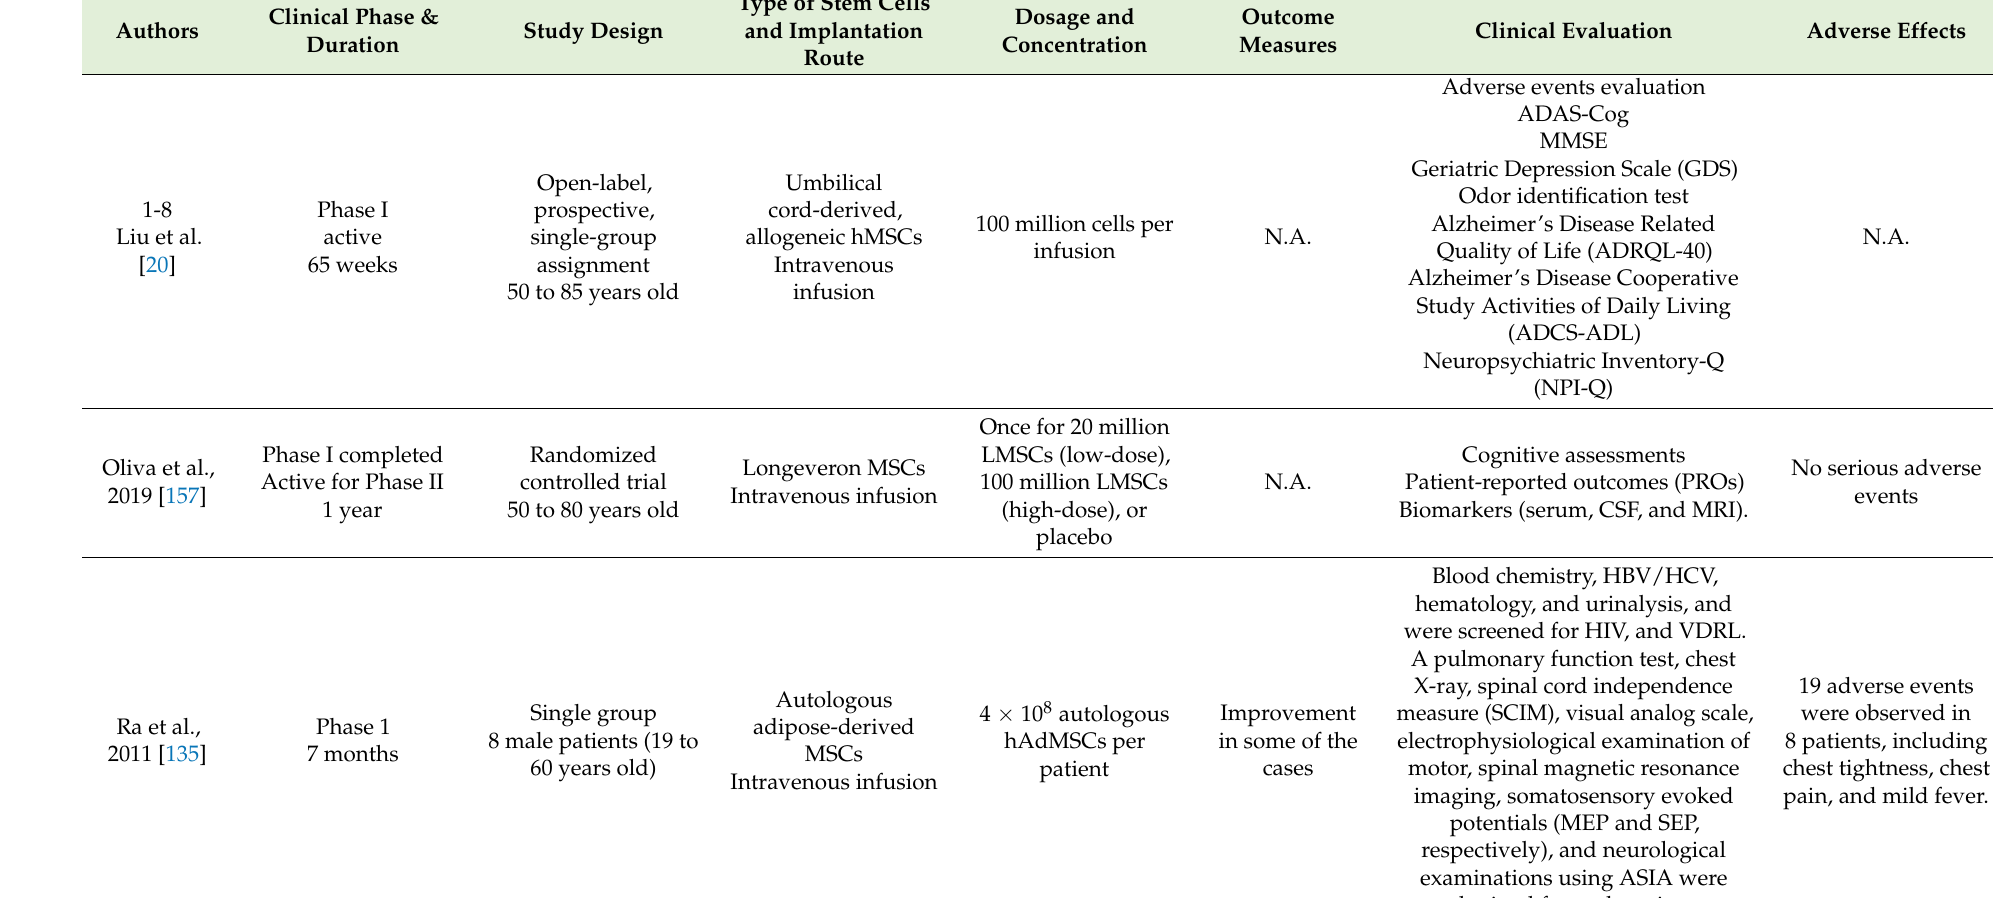
Table 3. Clinical studies investigating the effectiveness or safety of stem cell therapies in AD